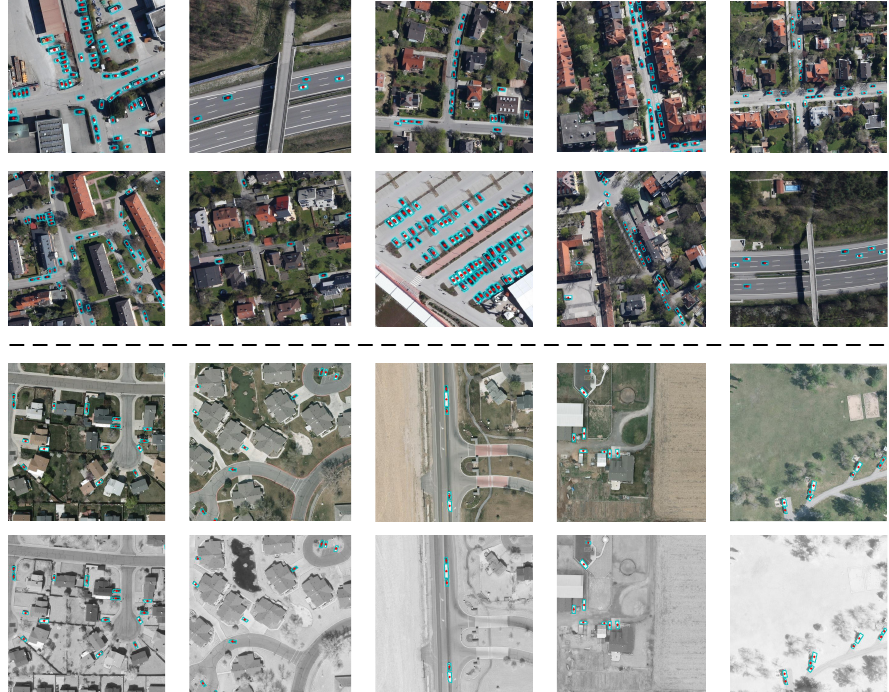
Figure 10. The figure shows some examples of our proposed SR-Net for vehicle detection in any direction. The first two rows visualize the test results in the DLR 3K Munich dataset. The second two rows visualize the test results in the VEDAI dataset (two image modes: RGB and NIR). The effect is better when viewed in a larger